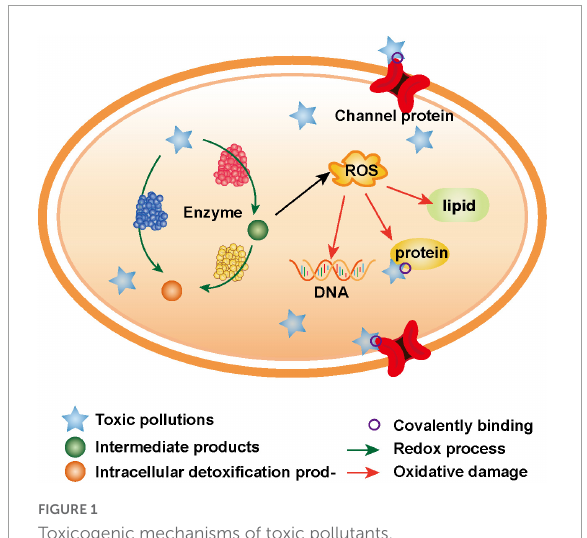
FIGURE1 Toxicogenic mechanisms of toxic